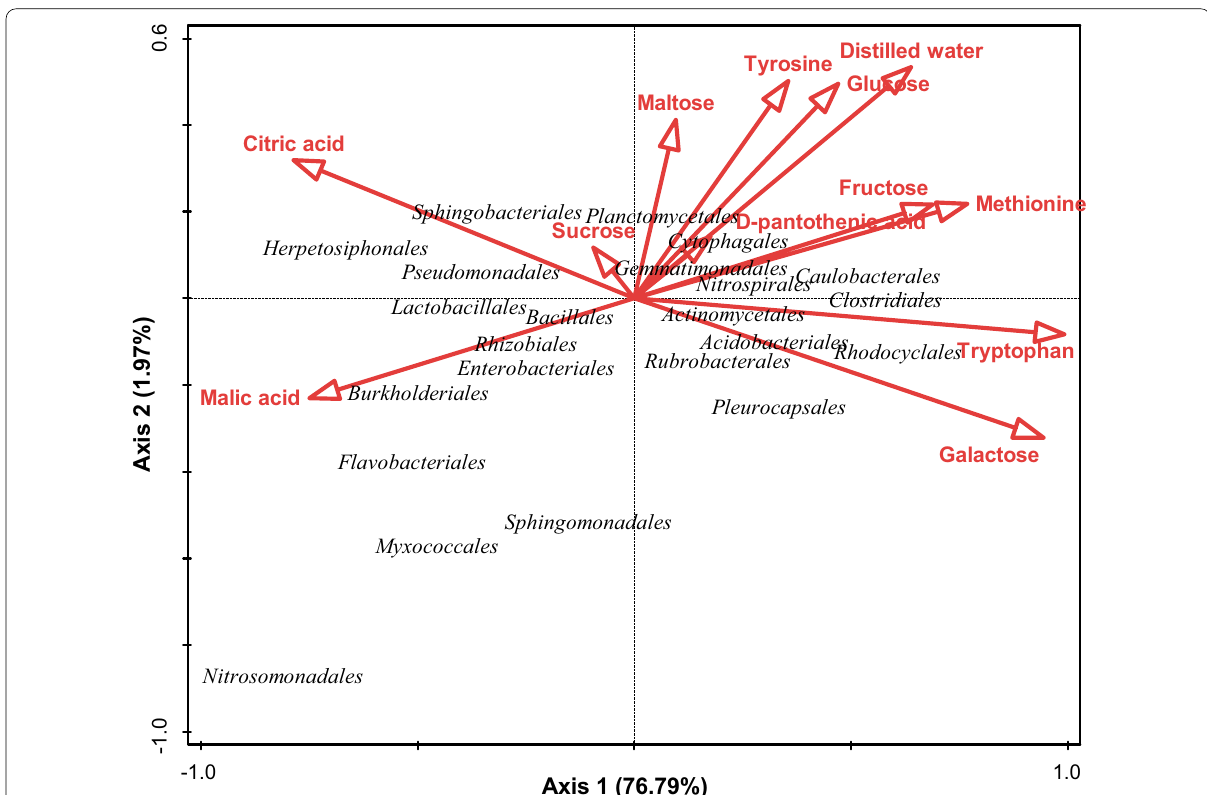
Fig. 9 The influence of carbon substrate utilization on the bacterial components (at the order level) of sunflower rhizosphere and bulk soils obtained from Ditsobottla and Kraaipan farms using canonical correspondence